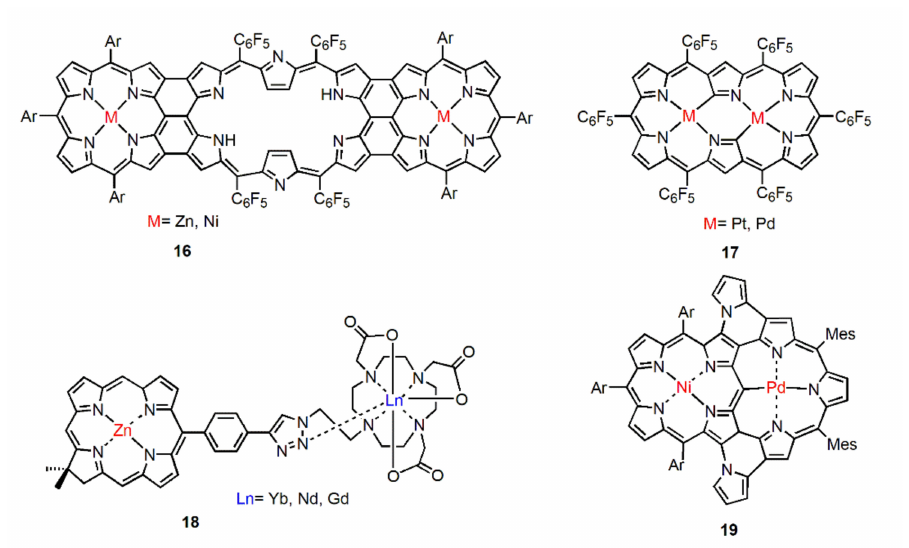
Figure 7. Chemical structure of some polypyrrole bridging